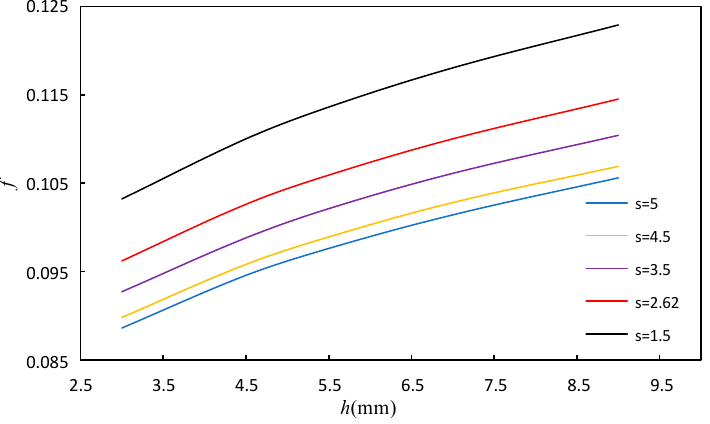
Figure 11. Effect of fin height and fin spacing on f . Figure 11. E ff ect of fi n height and fi n spacing on f. It can be seen from Figures 10 and 11 that under the given fin spacing s , the j factor and f factor increase with the increase in fin height. When the fin height is fixed, the j factor increases with the increase in fin spacing, while the f factor decreases. The increase in h can increase the secondary heat transfer area and enhance the heat transfer, while increasing the friction resistance. The increase in the spacing s can increase the amount of fluid in the flow space, thus strengthening the heat transfer. At the same time, the increase in fin spacing s takes more fluid away from the wall, and the impact of the wall shear stress on the fluid is reduced, leading to the decrease in the flow pressure, and then the f factor decreases.